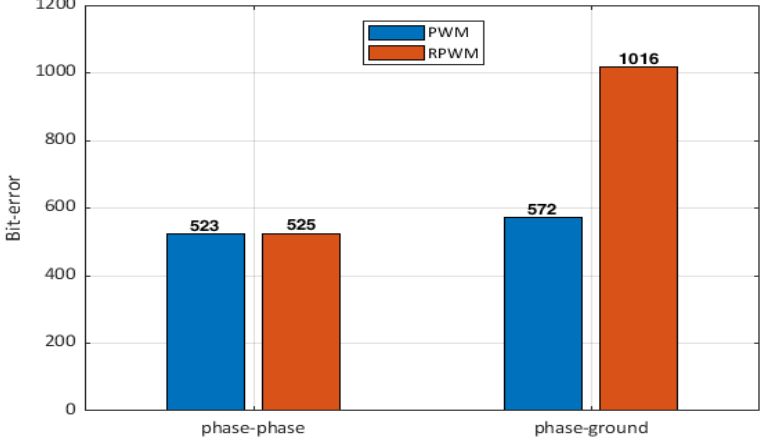
Figure 14. Bit error rate with coupling/decoupling networks connected between two phases or between one phase and ground (25 kHz switching frequency).